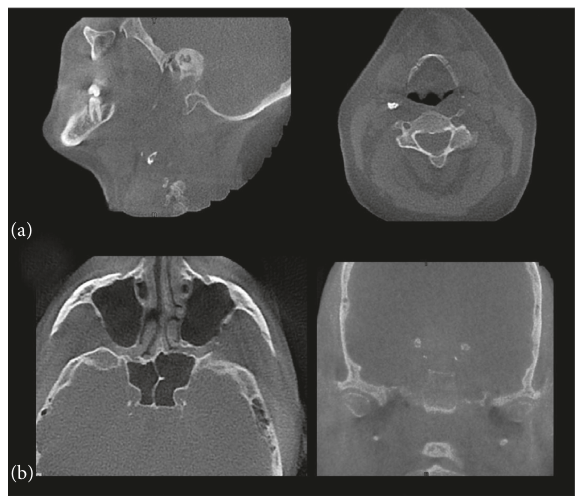
Figure 1: (a) Sagittal and axial CBCT images showing extracranial and (b) axial and coronal CBCT sections showing intracranial carotid artery